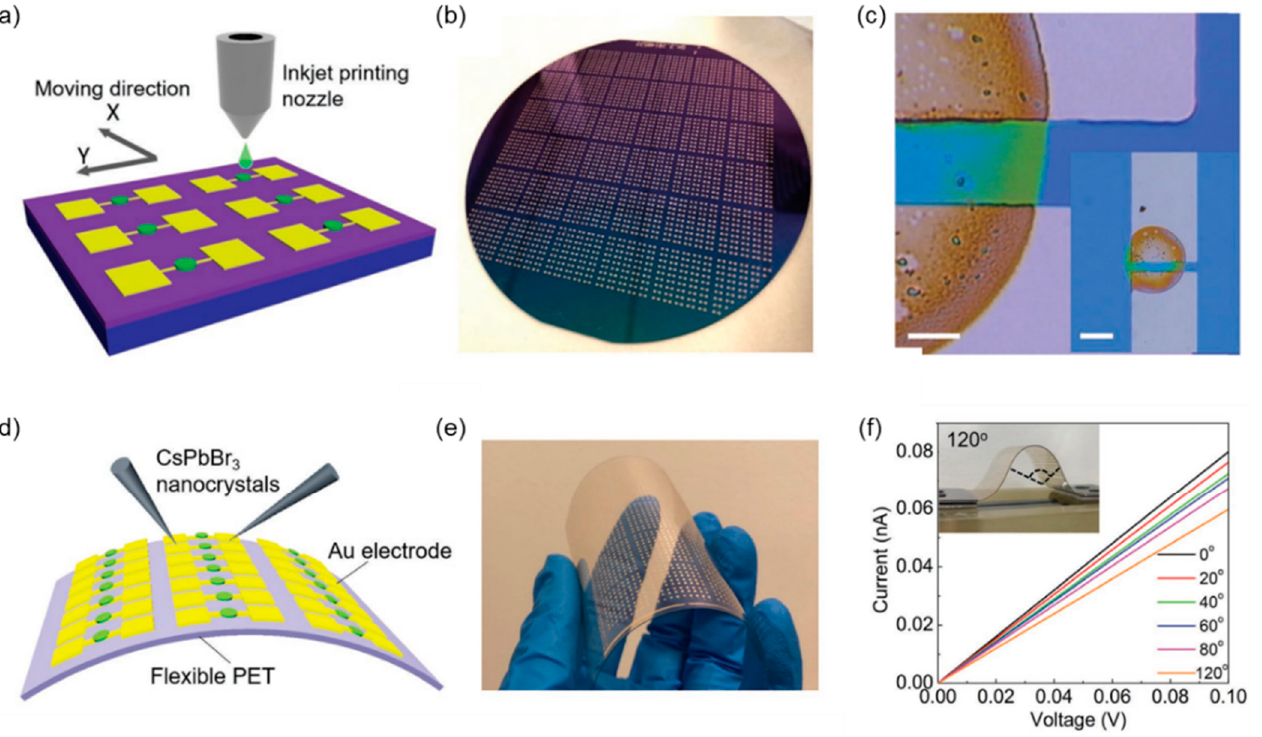
Figure 7. Low-dimensional all-inorganic perovskites-based X-ray detectors. Reprinted with permis- sion from Ref. [42]. 2019, Wiley. ( a ) Schematic diagram of a perovskite-based device manufactured by inkjet printing. ( b ) Photography of an X-ray detector array on a 4-inch wafer. ( c ) Optical imaging equipment with the printing of quantum-dot film. Scale: 5 μ m. Illustration: Low-power image. Scale: 50 μ m. ( d ) Chemical reactions of flexible perovskite-based X-ray detector arrays on polyethylene terephthalate (PET) substrates. ( e ) Photography of flexible devices under bending. ( f ) Current and voltage curves of flexible device arrays at different bending angles under X-ray irradiation with 7.33 mGy air s − 1 and 0.1 V bias voltages. Inset: Real device showing 120° bending.